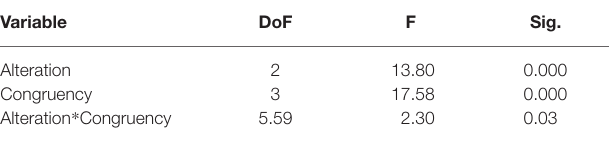
TABLE 2 | ANOVA results for number of fixations on hand AOI. Variable DoF F Sig. Alteration